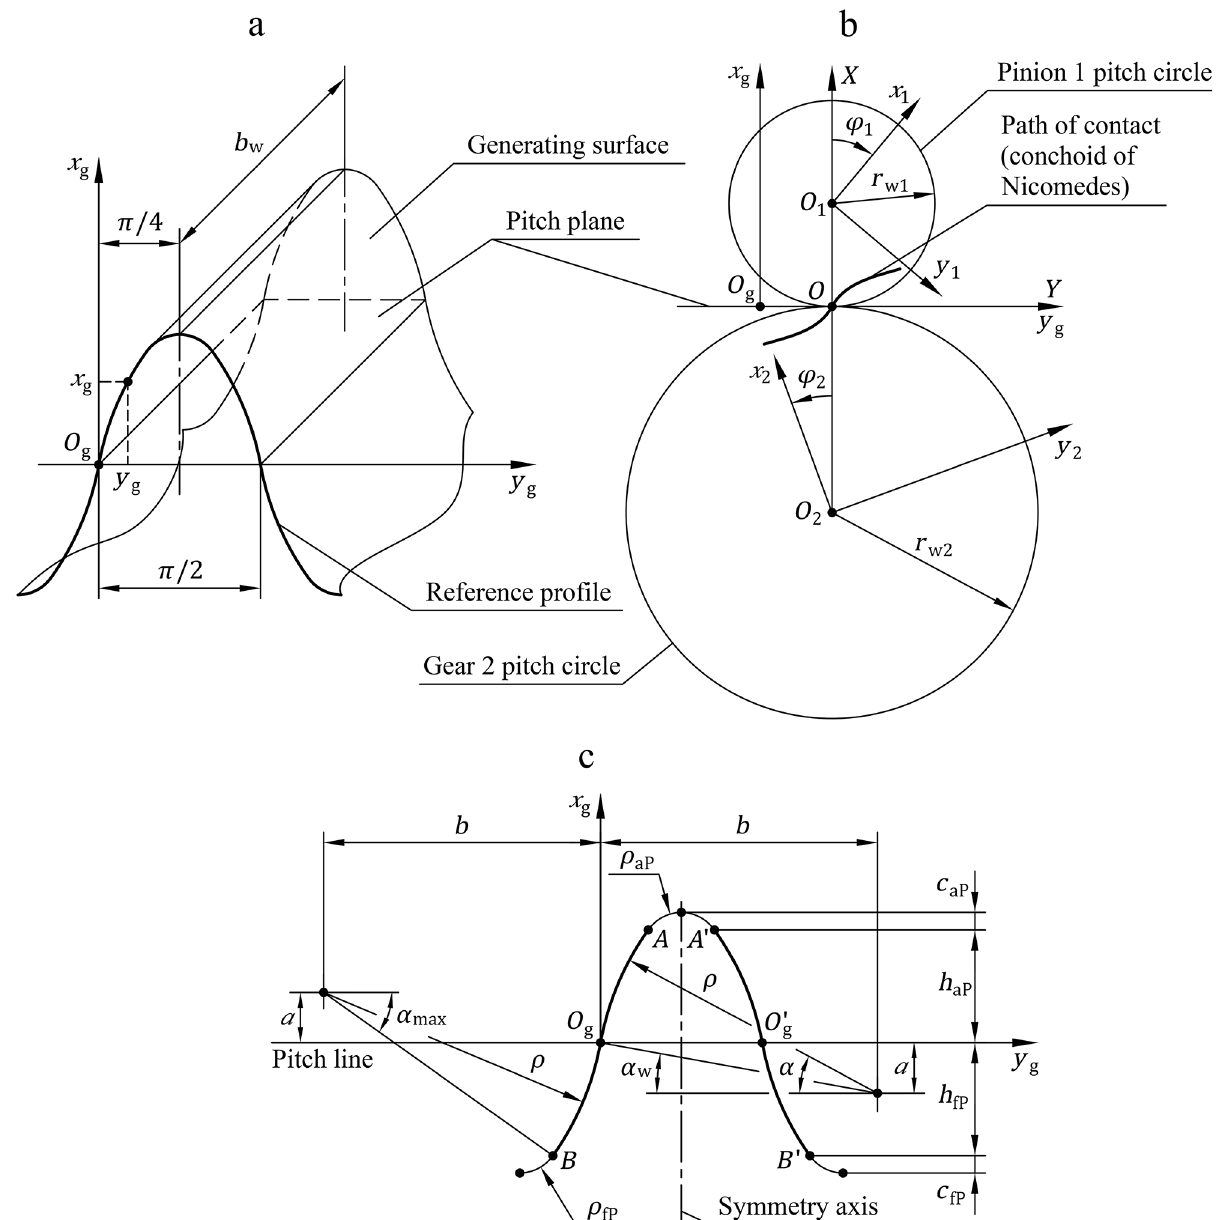
Fig. 1. Geometry of conchoidal gears: (a) generating surface; (b) pinion 1 and gear 2; (c) reference pro fi